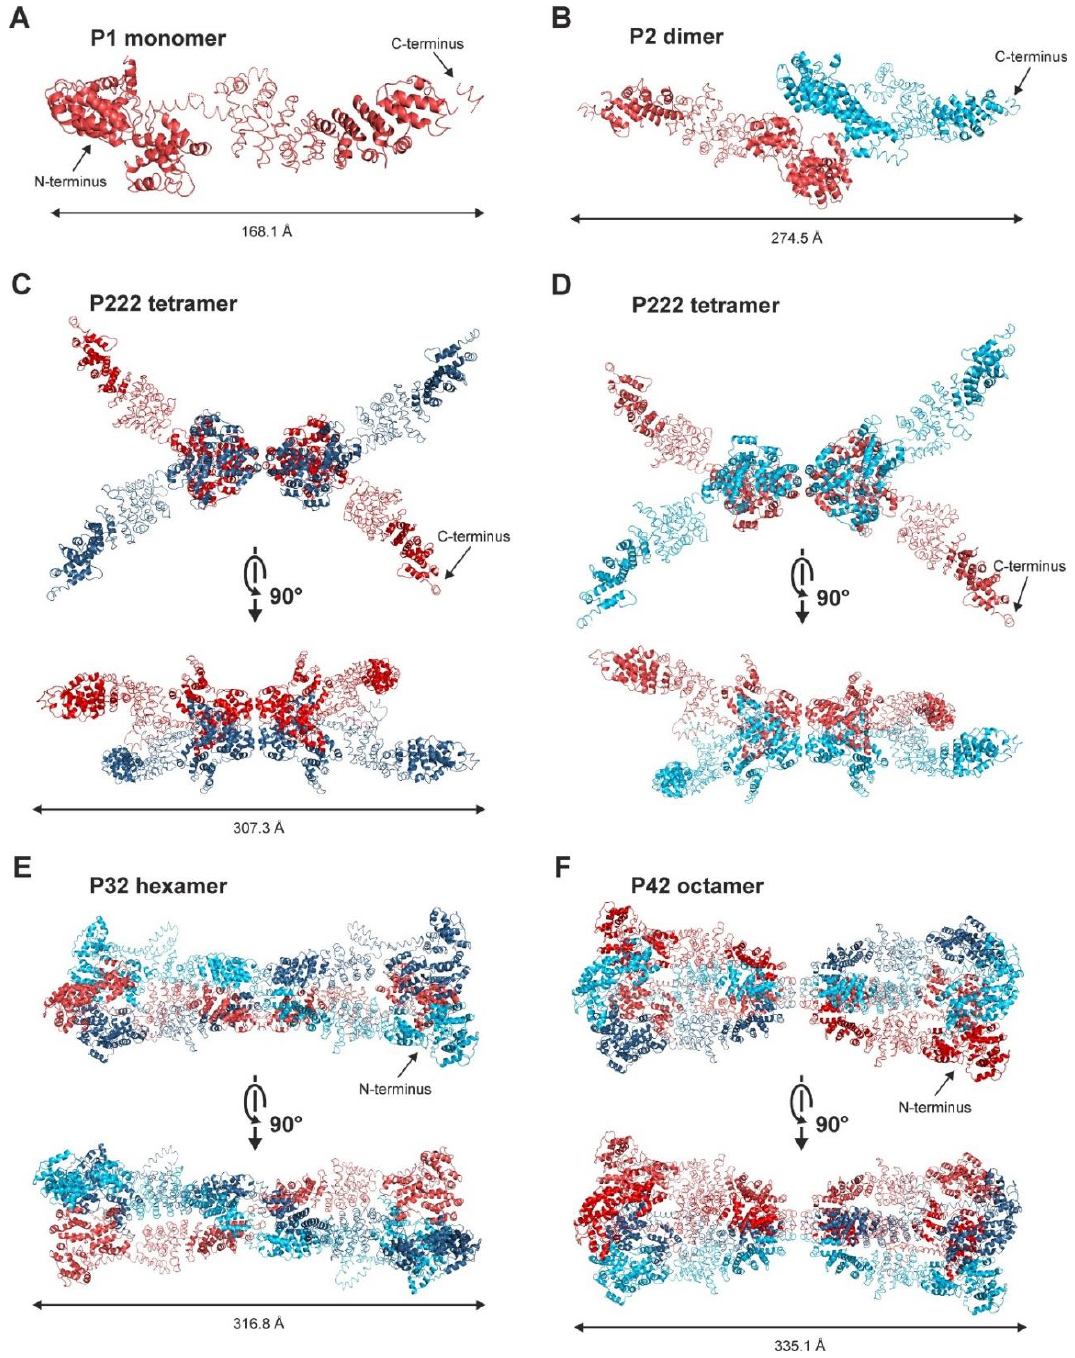
Figure 6. Oligomeric states of SAUL1. SASREF derived oligomeric models of SAUL1. Monomeric subunits are represented by one color. ( A ) The monomeric model was generated using SEC-SAXS experimental data. The model was built using CORAL and refined with SREFLEX . All oligomeric states are based on this model. ( B ) P2 dimer model fitted to a concentration of 0.43 mg ml −1 . P222 tetrameric model fitted to SAUL1 solutions with concentrations of ( C ) 0.98 and ( D ) 3.96 mg mL −1 . ( E ) The P32 hexameric and ( F ) P42 octameric models were fitted to a SAUL1 concentration of 0.43 mg mL −1 .